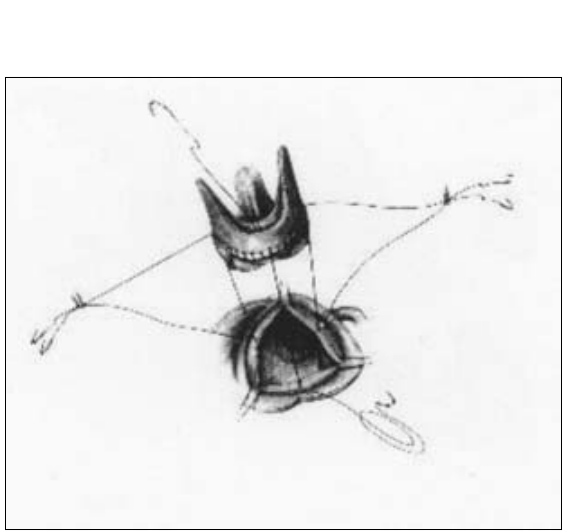
Fig. 3 - Sutura com pontos profundos e eq(cid:252)idistantes no seio a(cid:243)rtico e na parede do xenoenxerto (reproduzida com permissªo do Dr. Mark F.